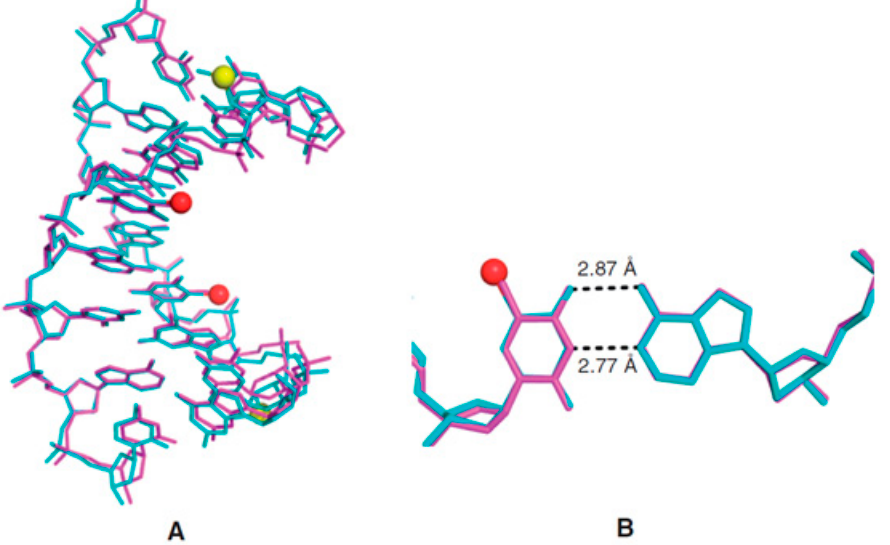
Figure 3. The global and local structures of the Te-DNA duplex. ( A ) The Te-dsDNA structure (in cyan; 1.50 Å resolution; PDB ID: 3FA1) is superimposed over the native one (in magenta; PDB ID: 1DNS). ( B ) The local structure of the TeT/A base pair (in cyan) is superimposed over the native T/A base pair (in magenta).